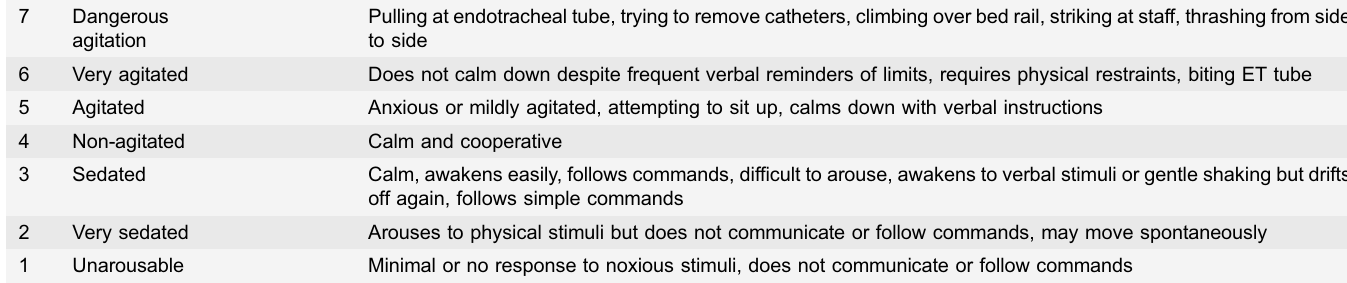
Table 1. Riker’s sedation-agitation scale